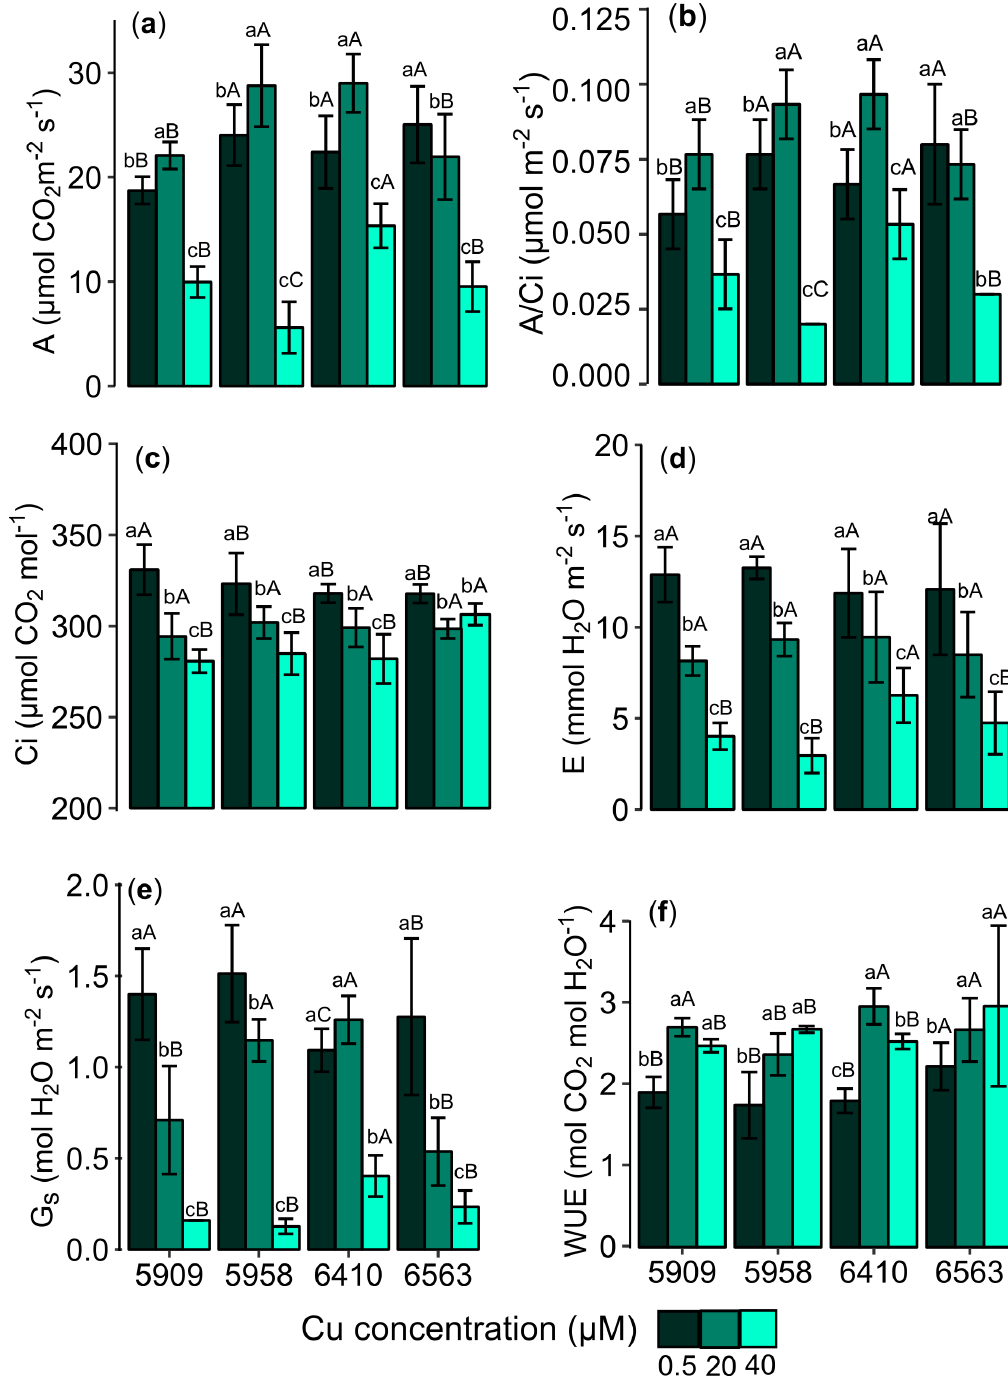
Figure 2 - Net photosynthetic rate ( a ), RuBisCo instantaneous carboxylation efficiency ( b ), intercellular CO concentration ( c ), transpiration rate ( d ), stomatal conductance ( e ) and water use efficiency ( f ) of four soybean cultivars (5909, 5958, 6410 and 6563) grown in nutrient solution at three different Cu concentrations (0.5, 20 and 40 µM). Capital letters indicate comparison between cultivars in the same Cu concentration. Lowercase letters indicate comparison between Cu concentrations in the same cultivar (p <0.05). Vertical bars represent ± standard